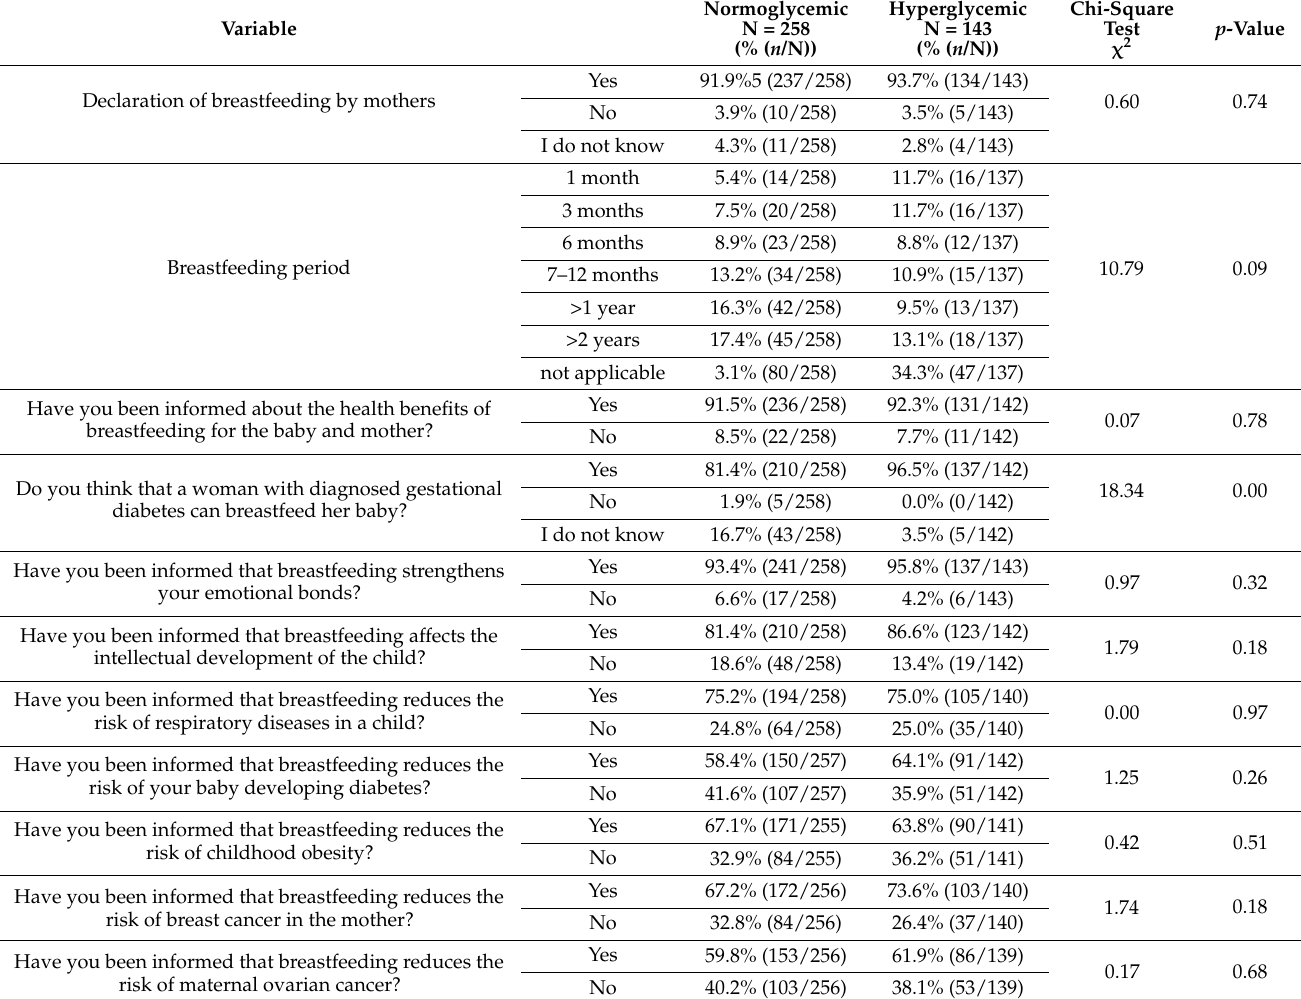
Table 6. Breastfeeding knowledge level in relation to maternal glycemic